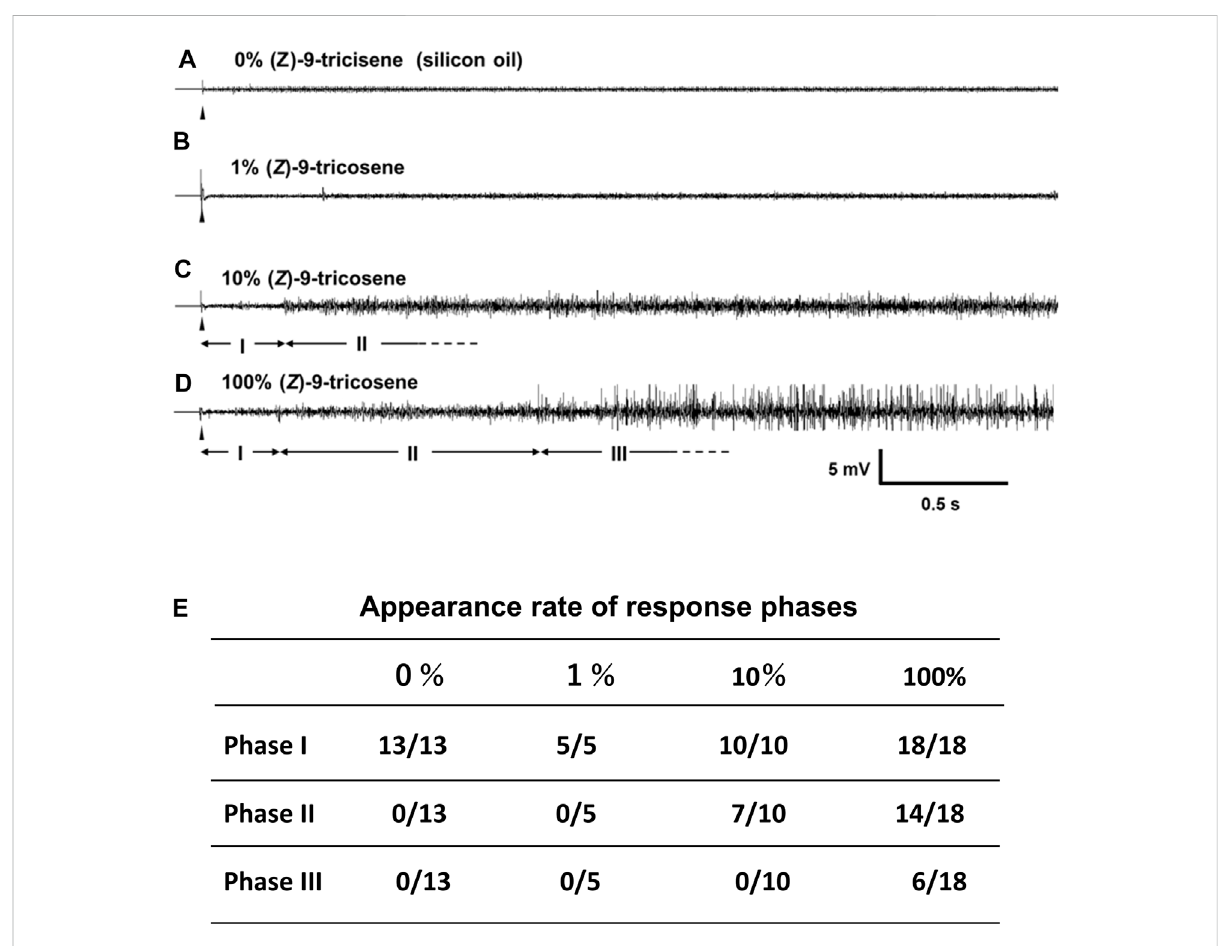
FIGURE 7 Singlesensillarresponsesofas.bsiconicumof C.japonicus tothecontactstimulationwith(Z)-9-tricosene. (A – D) Therepresentativeresponses to 0 (silicon oil), 1, 10 and 100% ( Z )-9-tricosene, respectively. Each trace indicates the fi rst 3-s-AC-recording after beginning of 6-s-stimulation (arrowheads). I, II and III are apparently different phases showing no impulse, multiple impulse units and multiple impulse units including some of large amplitudes, respectively. (E) Stimulation-dependent appearance of three phases, I, II and III, presented by the number of recordings including each phase per total number of